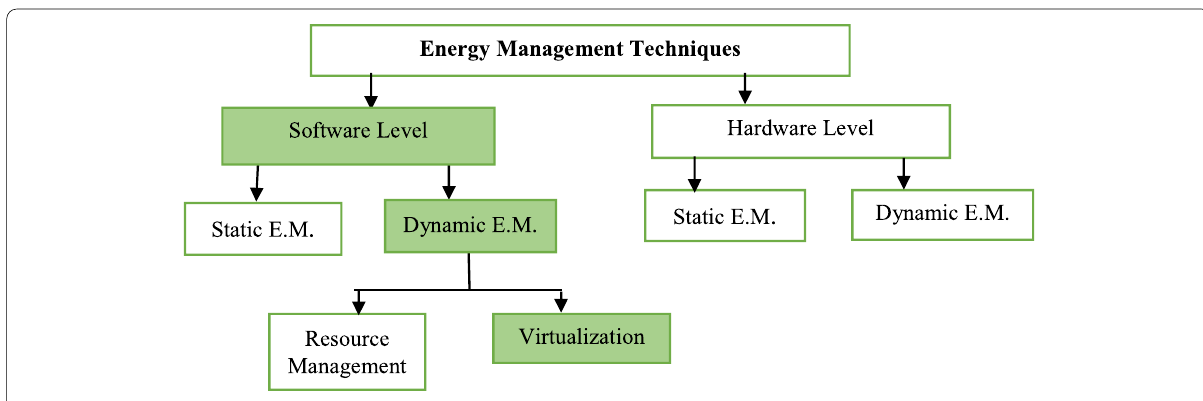
Fig. 1 Classifications of energy management